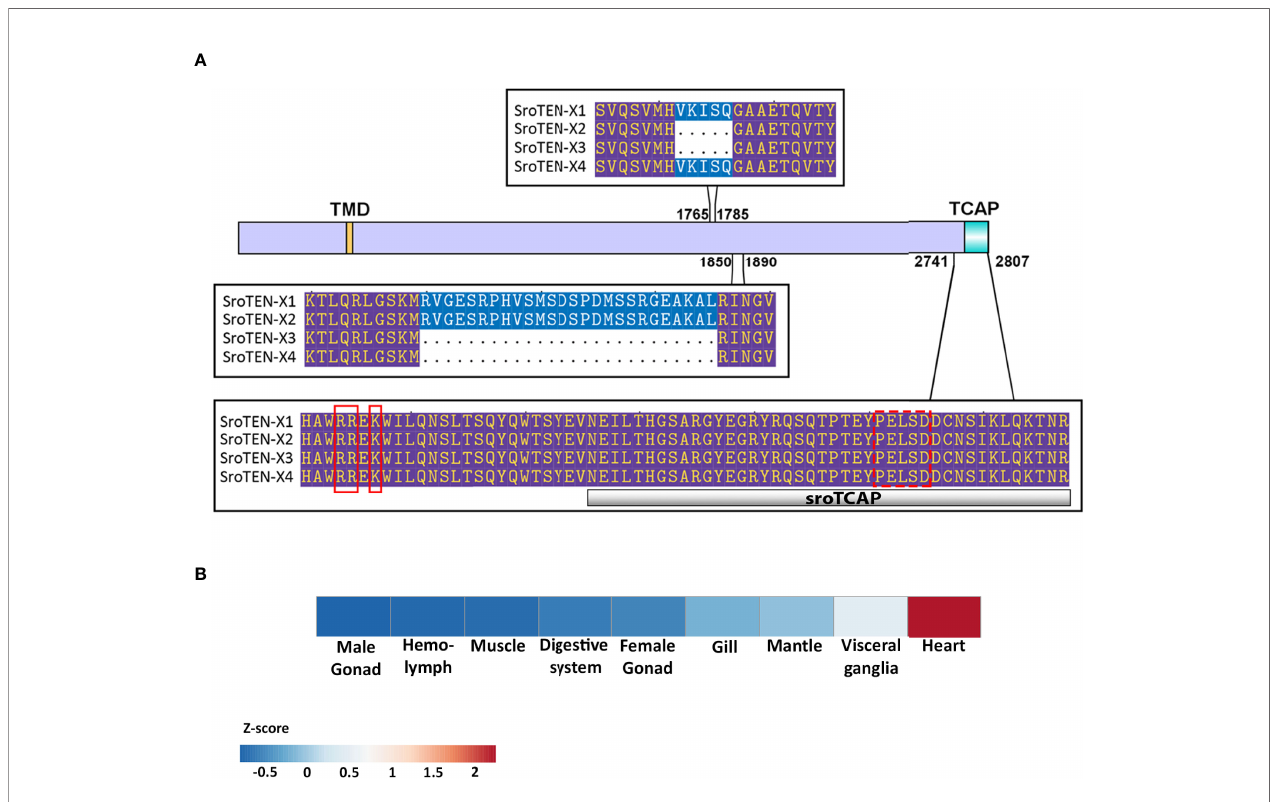
FIGURE 1 | Teneurin predicted amino acid sequence and gene expression in SRO. (A) S. glomerata teneurin splice variants; blue shading represented regions that were present in two out of the four isoforms. Purple shading indicates 100% sequence similarity. TMD- a single transmembrane domain. The amino acid sequence of the synthesized sroTCAP peptide (42 aa) used in this study is shown as a grey bar. Solid red boxes depict predicted cleavage sites (leading to 60 aa TCAP), and the dotted red box shows the conserved PELSD motif. (B) Heatmap of teneurin expression in different SRO tissues, normalized with Z-score